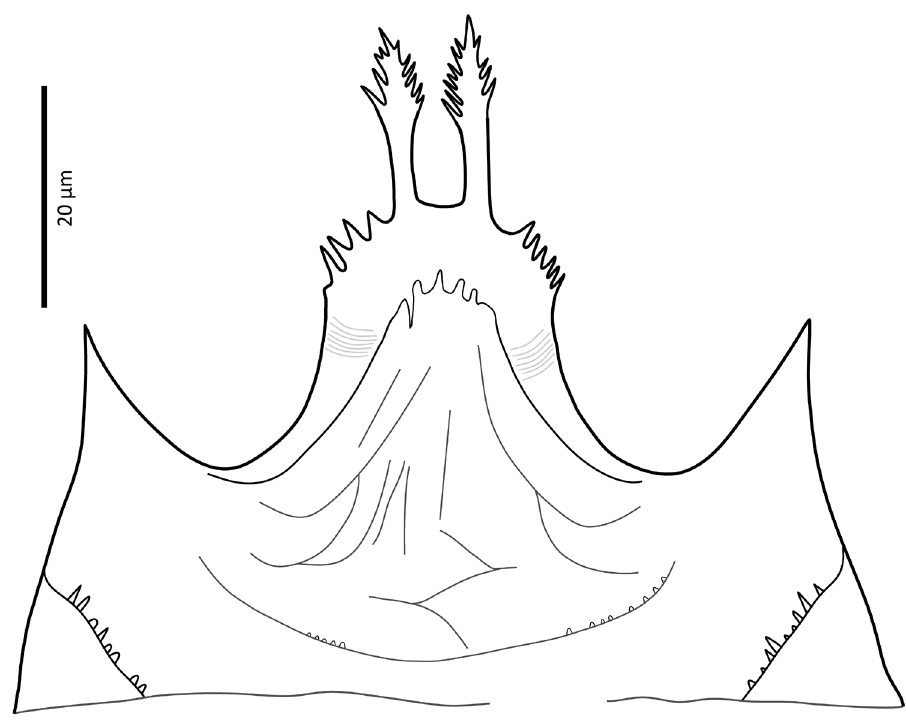
Figure 6. Zygoseius papaver sp. n., female,